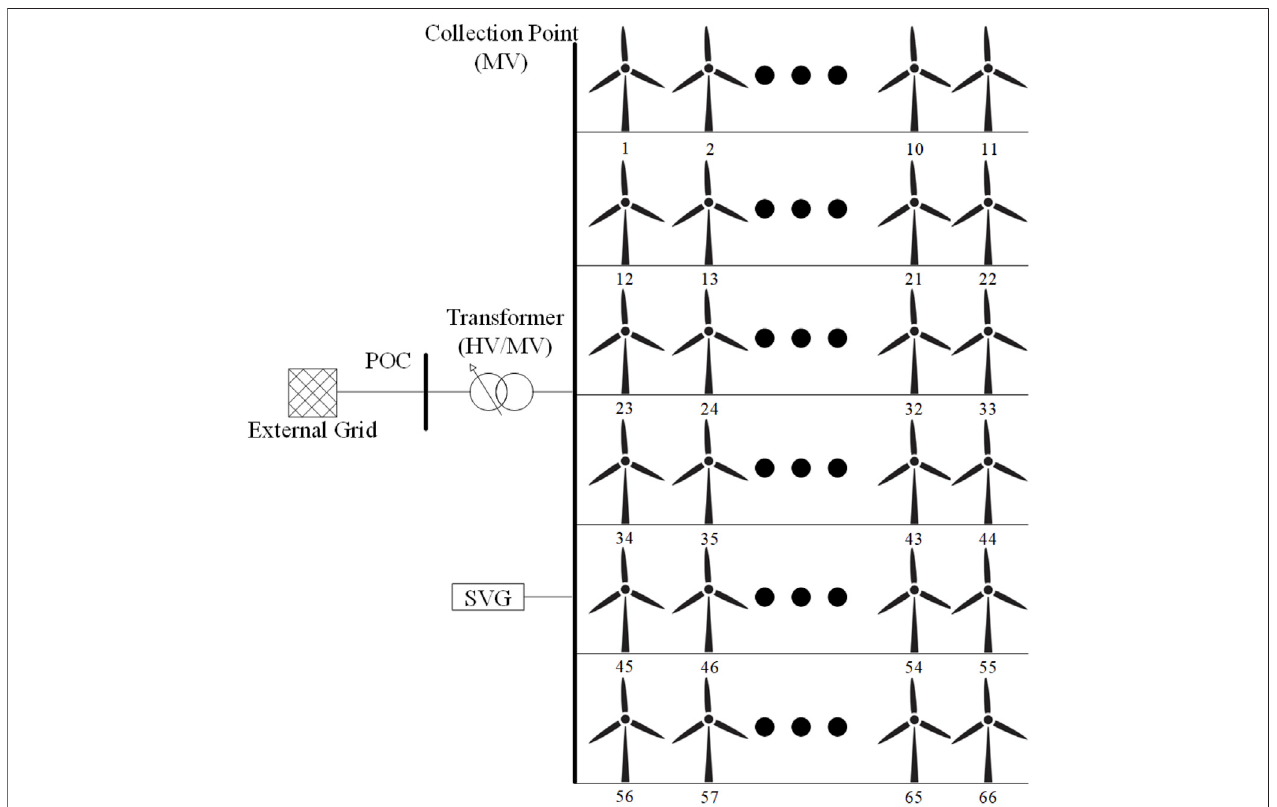
FIGURE 1 | Strategy mechanism for reactive power control of wind